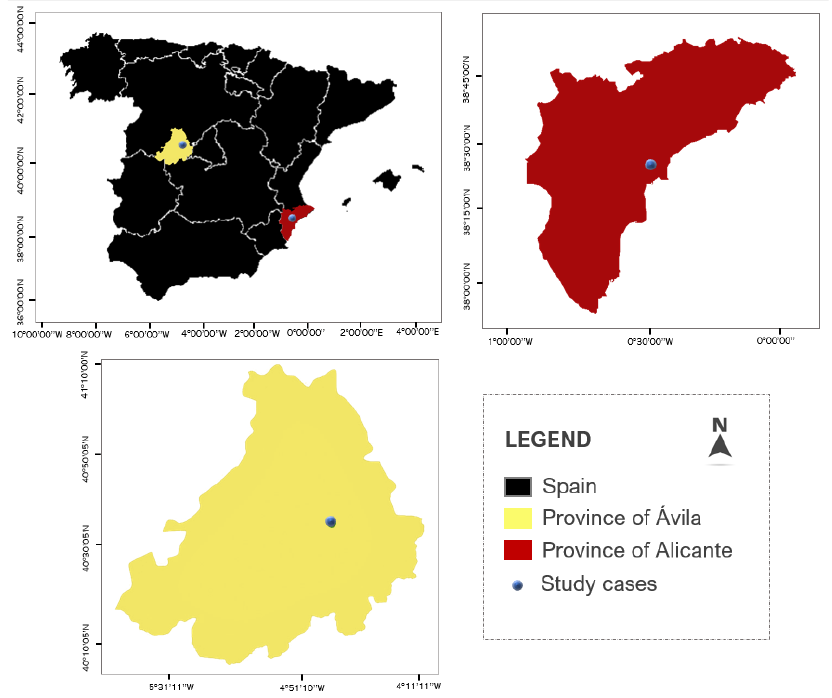
Figure 3. Location of the areas included in the present research. * Coordinates are expressed in latitude and longitude.